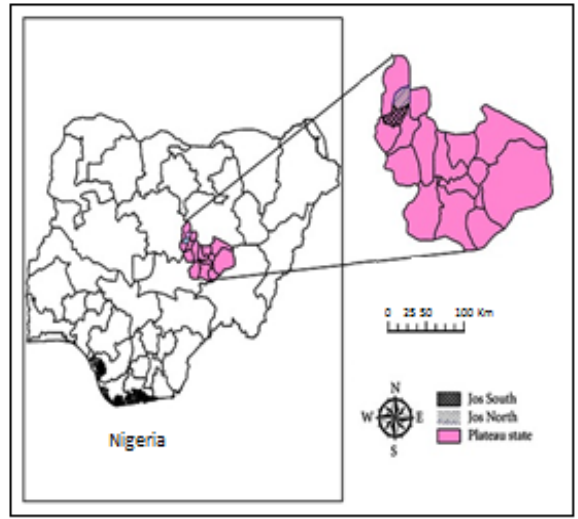
Figure 1. Map of Nigeria showing Plateau